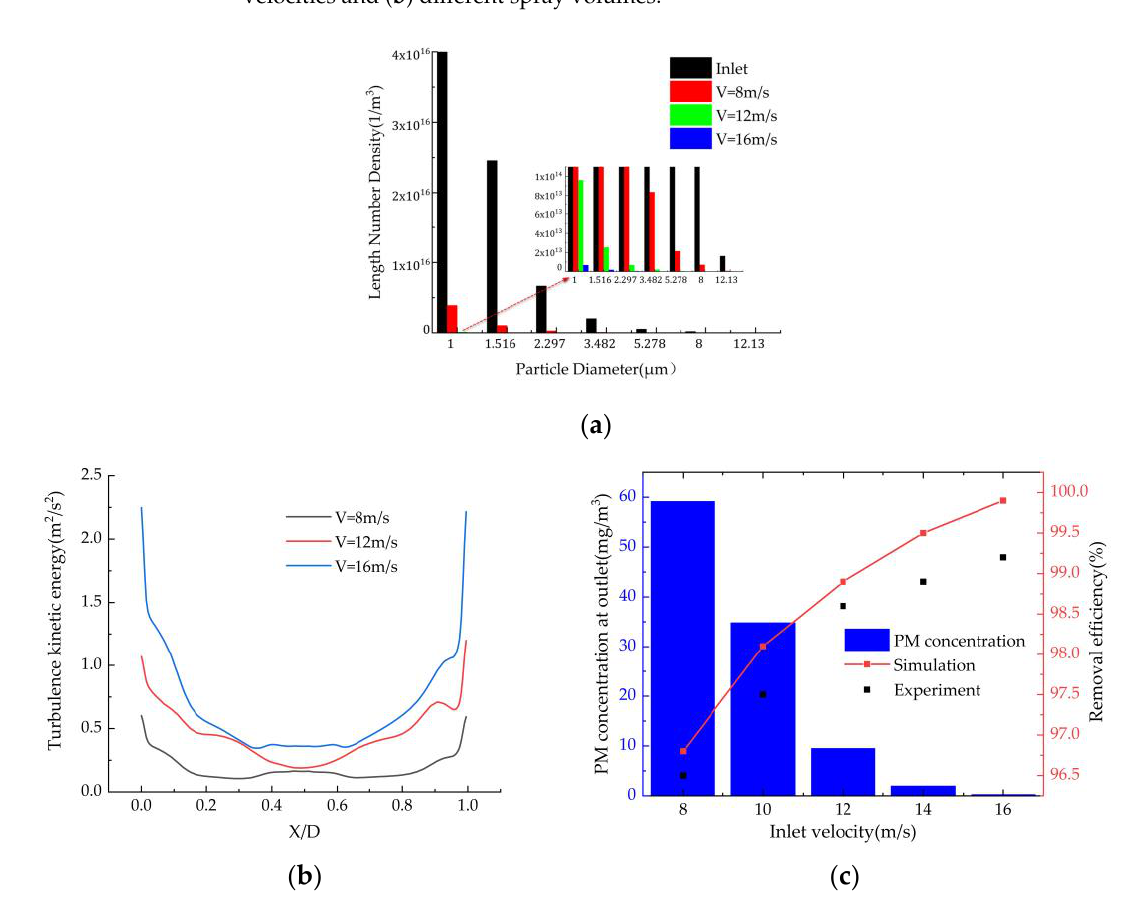
Figure 6. Effect of the gas velocity on the ( a ) particle number density, ( b ) turbulent kinetic energy at Z = 850 mm, and ( c ) particle concentration and removal efficiency.